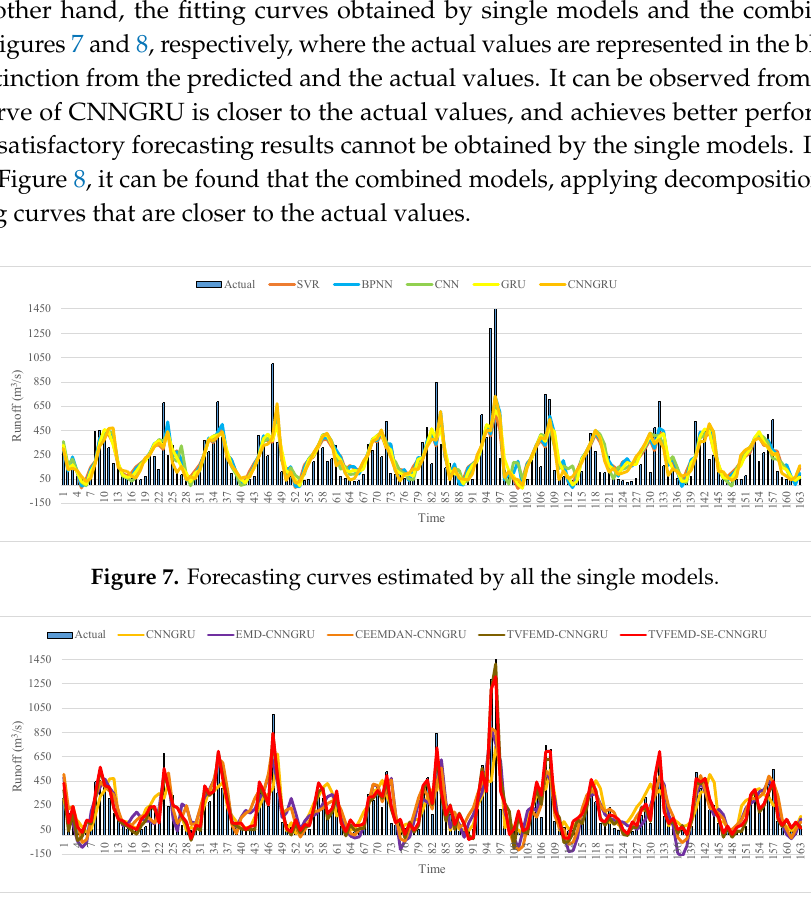
Table 6. Indicator decline ratios and the Diebold–Mariano (DM) test results illustrating the performance improvement of the proposed model.